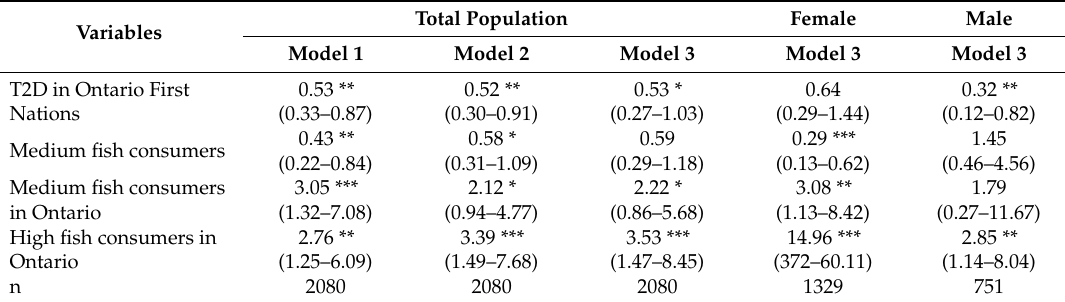
Table 4. Odds ratios (ORs) of the association between frequency of fish consumption and dietary POP exposure with type 2 diabetes prevalence (T2D) in Ontario compared to Manitoba First Nations.